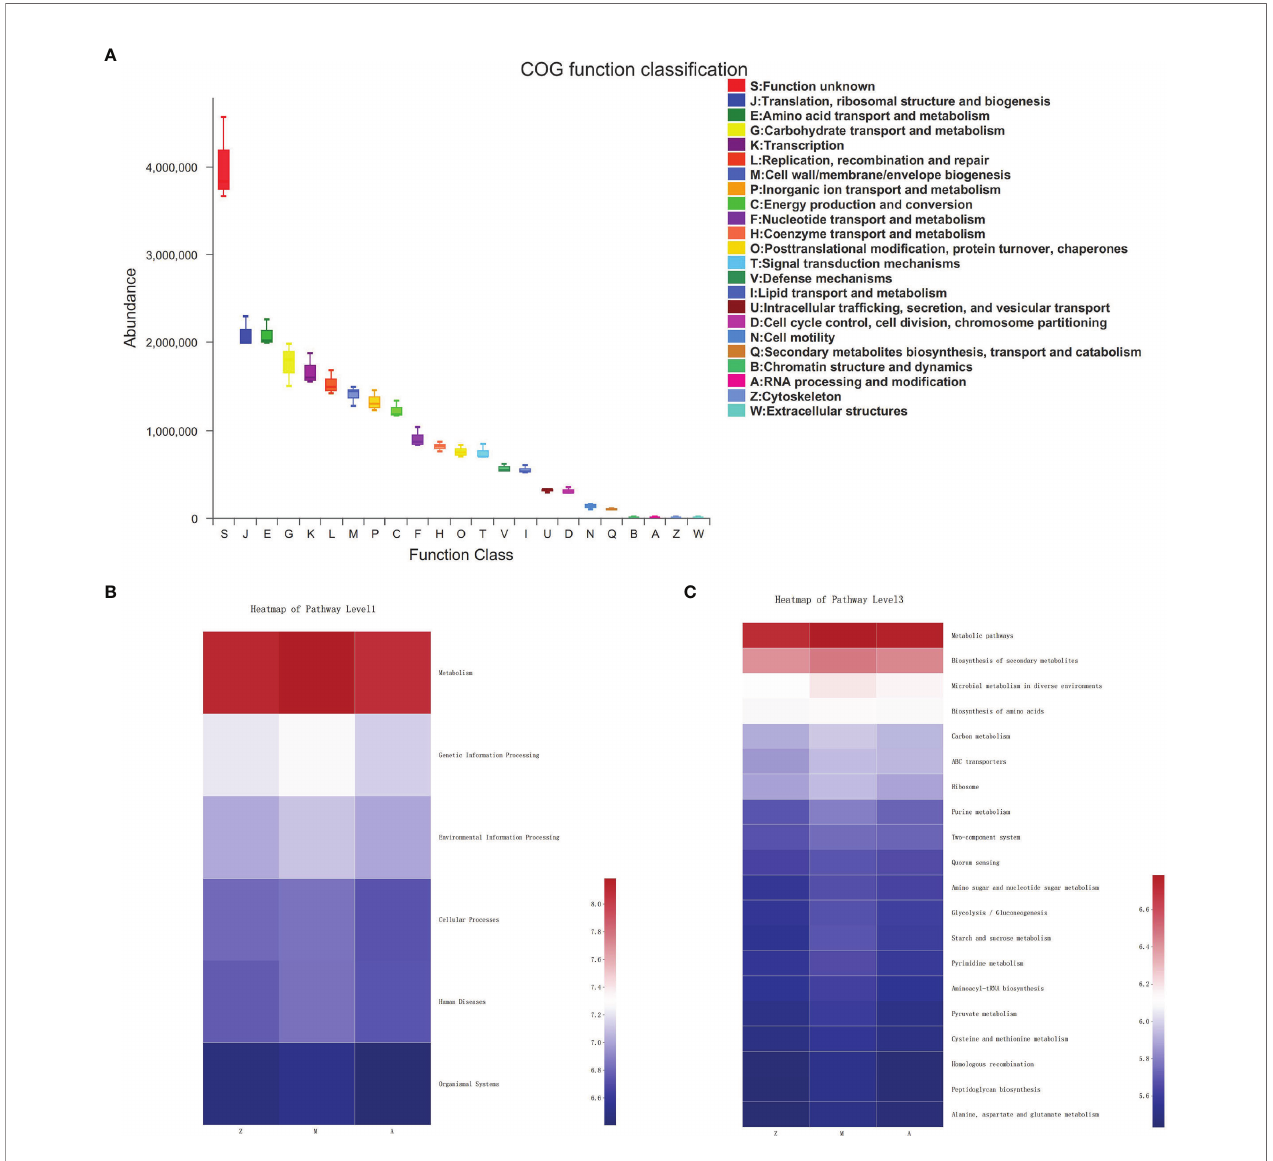
FIGURE 5 | Predictive functional pro fi ling of microbiota community. Z, control group; M, model group; A, treatment group. (A) COG function classi fi cation. (B) KEGG Pathway Level 1. (C) KEGG Pathway Level